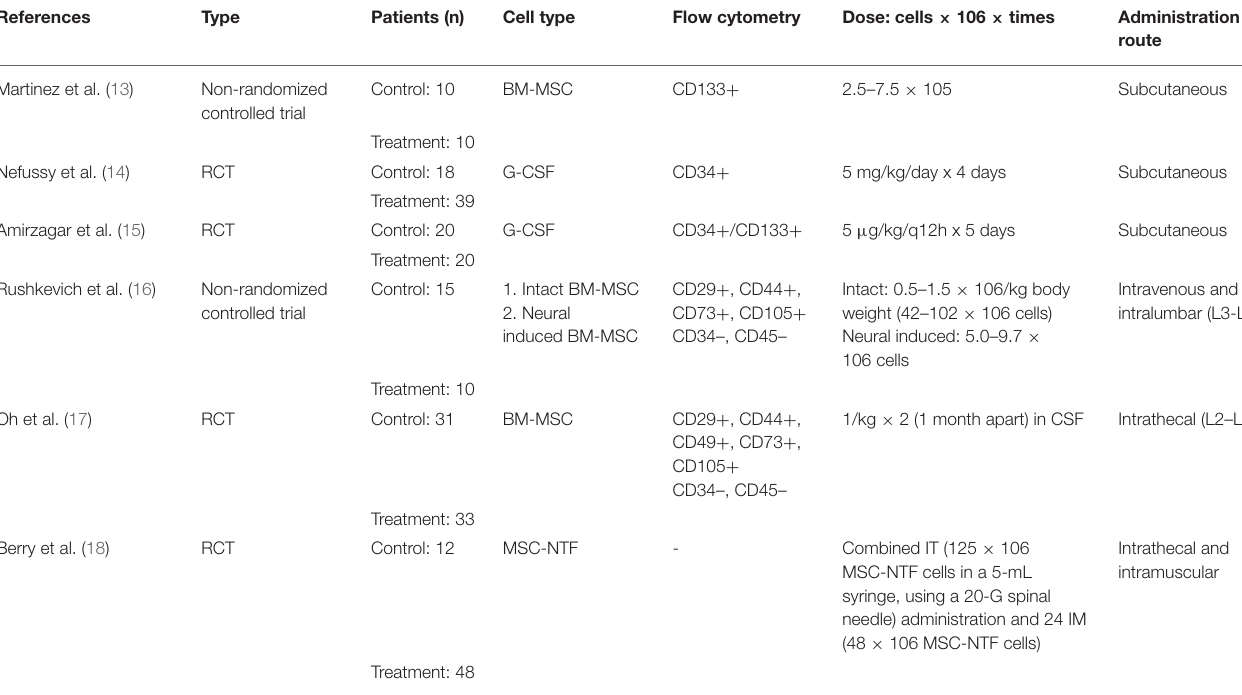
TABLE 1 | Model for study and stem cell